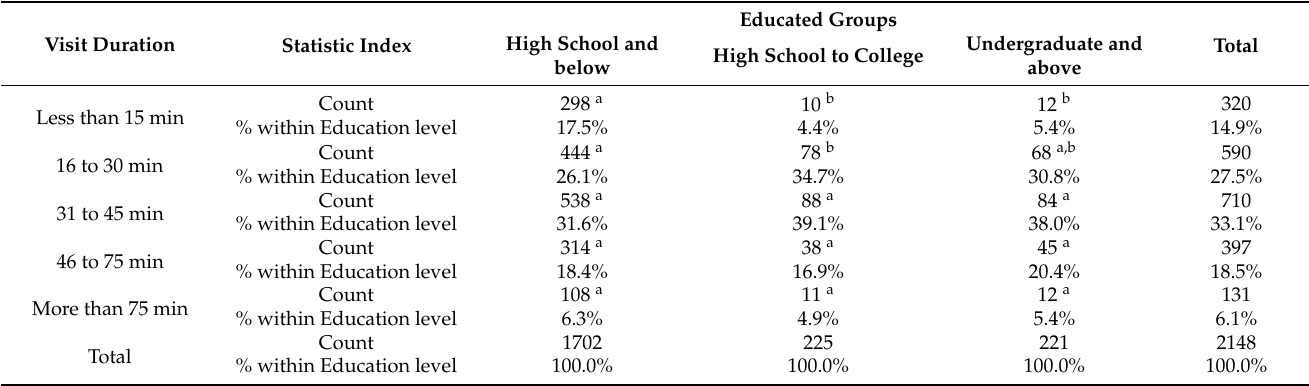
Table 4. Comparison of statistics for visit duration among different education groups and results of z-test, suggesting the differences.